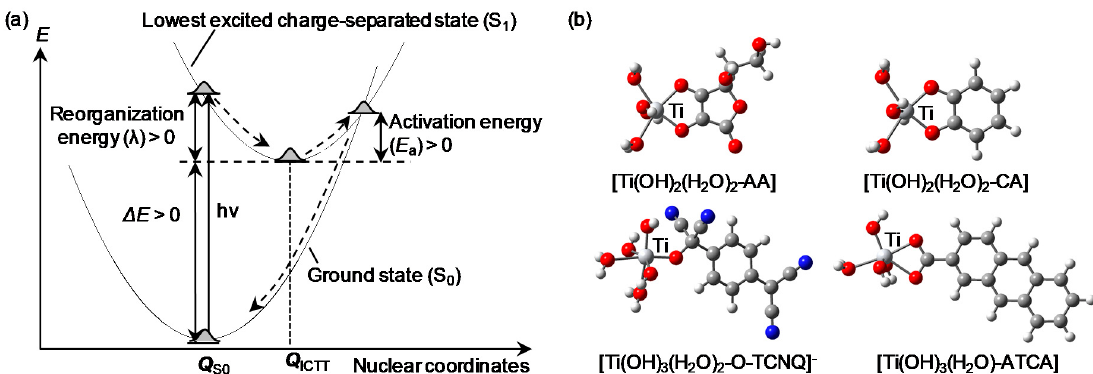
Figure 7. ( a ) Potential energy curves of the ground state (S 0 ) and the lowest excited charge-separated state (S 1 ) and ( b ) DFT optimized structures of the model complexes in the S 0 state. Gray: carbon, white: hydrogen, blue: nitrogen, red: oxygen, large white: titanium atom. Adapted with permission from Reference 2. Copyright 2015 the PCCP Owner Societies.